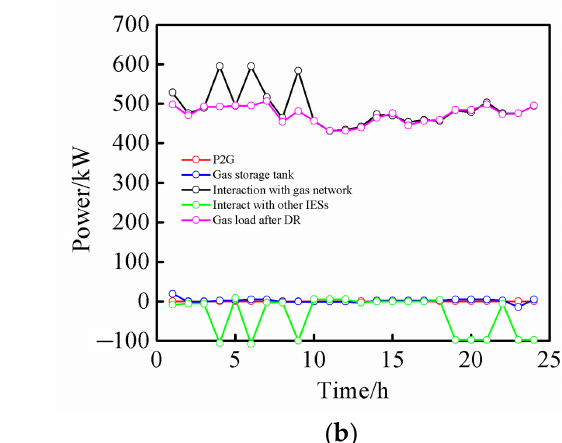
( b ) Figure 10. Worst scenario set of Subsystem 1 under Scenario 4. ( a ) Photovoltaic. ( b ) Electric load.